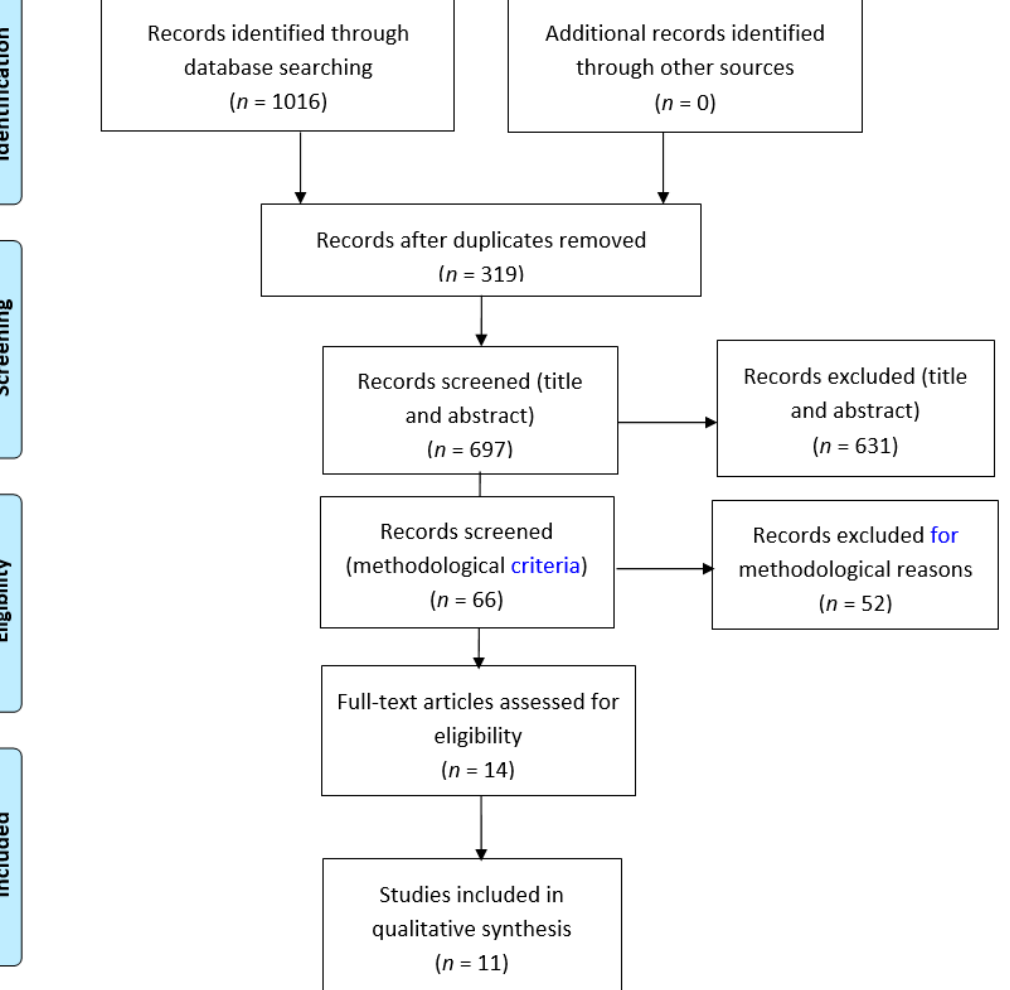
Figure 1. PRISMA flow diagram [19]. For more information, visit www.prisma-statement.org. Table 1. Instrument included.